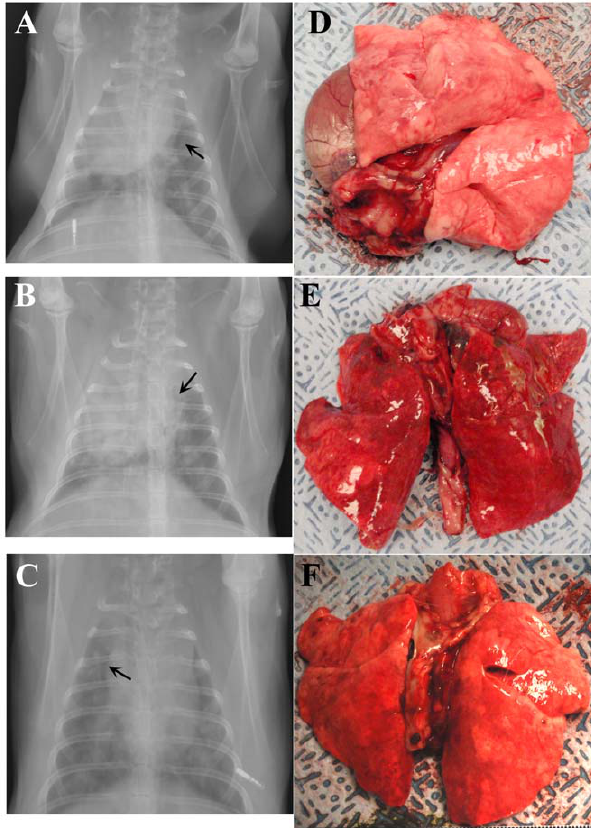
Figure 5. Radiographs and gross pathological changes in lungs demonstrating development of pneumonic tularemia in rab- bits. Anterioposterior radiographs (A–C) taken of three anesthetized rabbits four days after infection with F. tularensis illustrating develop- ment of bilaterial pneumonia. Arrows on radiographs indicate presence of air bronchograms. Pictures of the lungs removed from those same three rabbits at necropsy on day 5 ( D,E ) or day 6 ( F ) after infection.